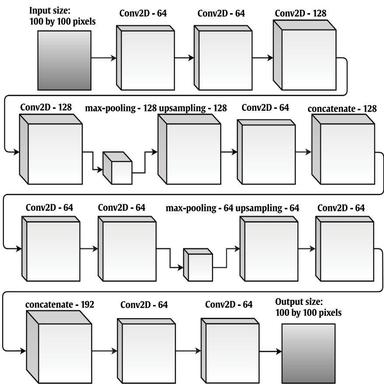
An overview of the convolutional layers of the U-Net network.